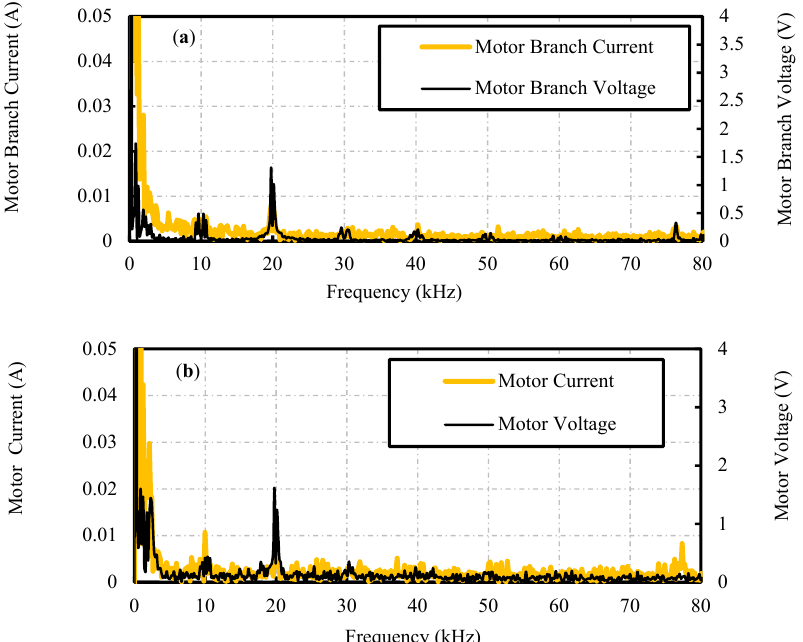
Figure 8. FFT of Experimental Results ( a ) Motor with Integrated Inductor ( b ) Motor with External Inductor.